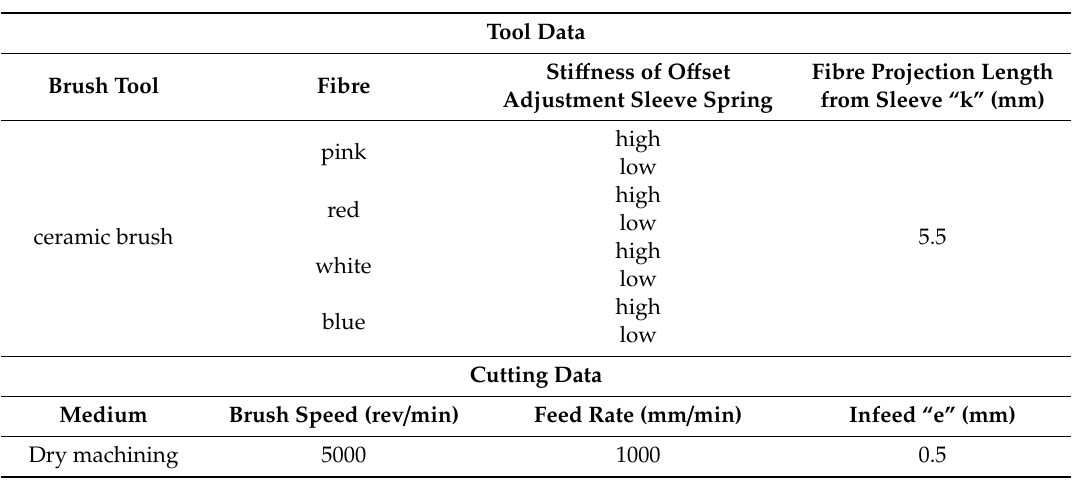
Table 2. Brushing conditions.